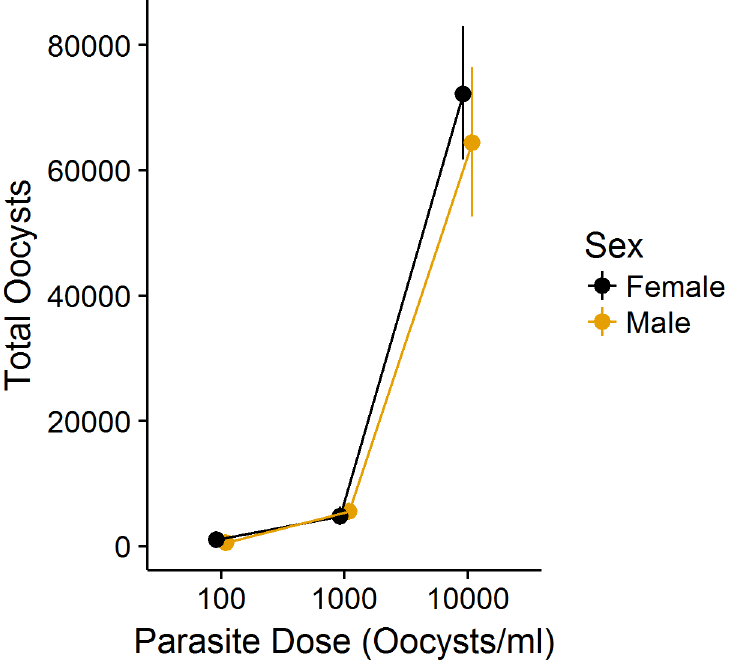
Fig 3. The mean total oocysts produced by mosquitoes exposed to different parasite dosages. Oocyst production within microcosms increaseswith dosageof parasite. Total oocysts produceddid not significantly vary with sex (Table C in S1 File). Both sexes receivedequal doses; mean values are ‘dodged’at each parasitedosage for visibility. Whiskers are bootstrapped 95% confidenceintervals (1000 replicates).